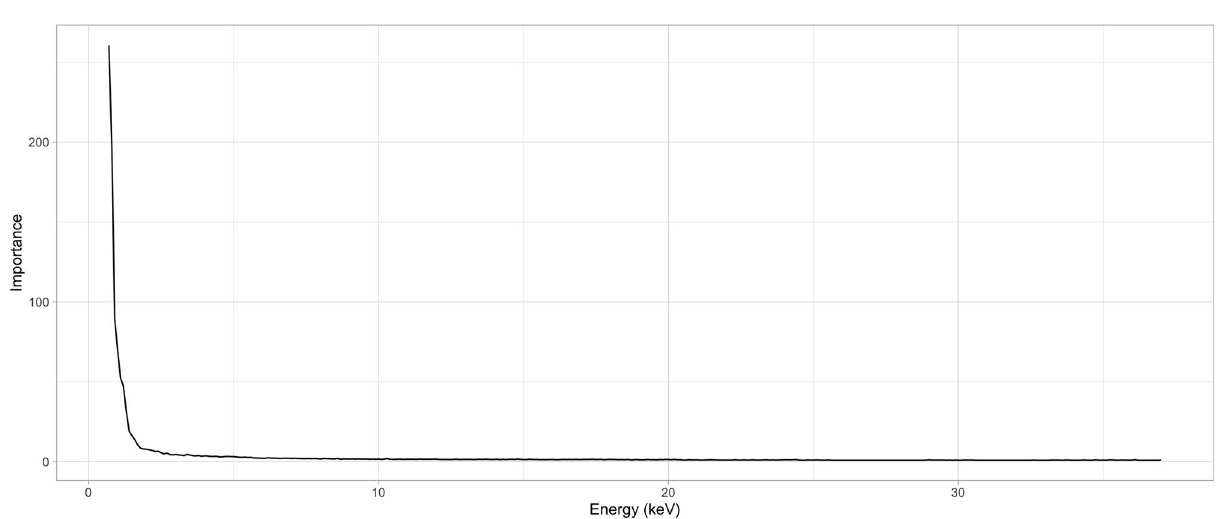
Figure 6. Importance features for the repeated dataset using categorical crossentropy as a loss function. Feature importance is largely identical to the full dataset.